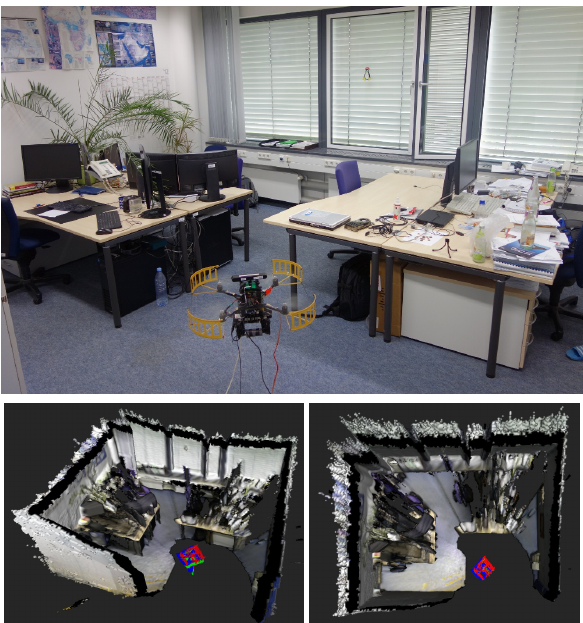
Figure 6: Office space with four desks scanned with our quadro- copter. The quadrocopter followed a pre-defined flight plan (rect- angle and rotations) to acquire the 3D model. Top: Image from external camera. Bottom: Reconstructed 3D models from side view and top view. The coordinate axes correspond to the esti- mated trajectory.